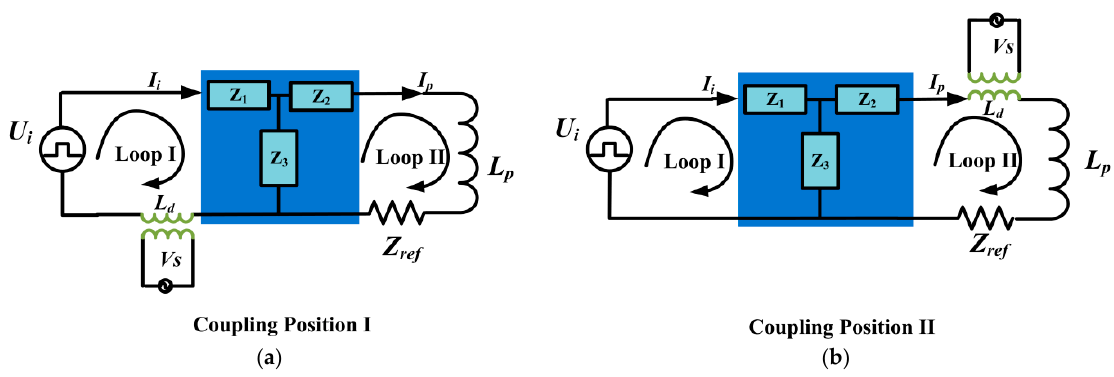
Figure 4. SWTPI structure with different coupling positions. ( a ) Coupling position I; ( b ) Coupling position II.